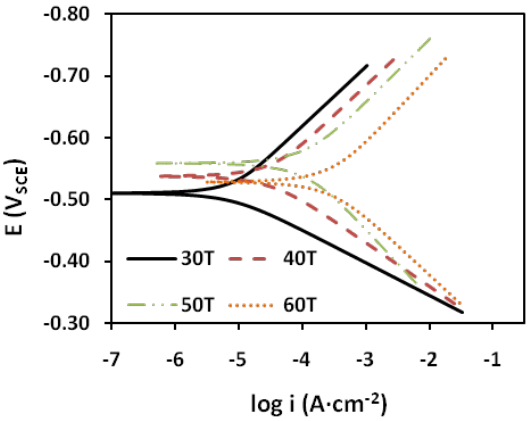
Figure 4. Potentiodynamic polarization curve for mild steel in 1.0 M HCl with 0.5 mM of the PMBH at various temperatures.